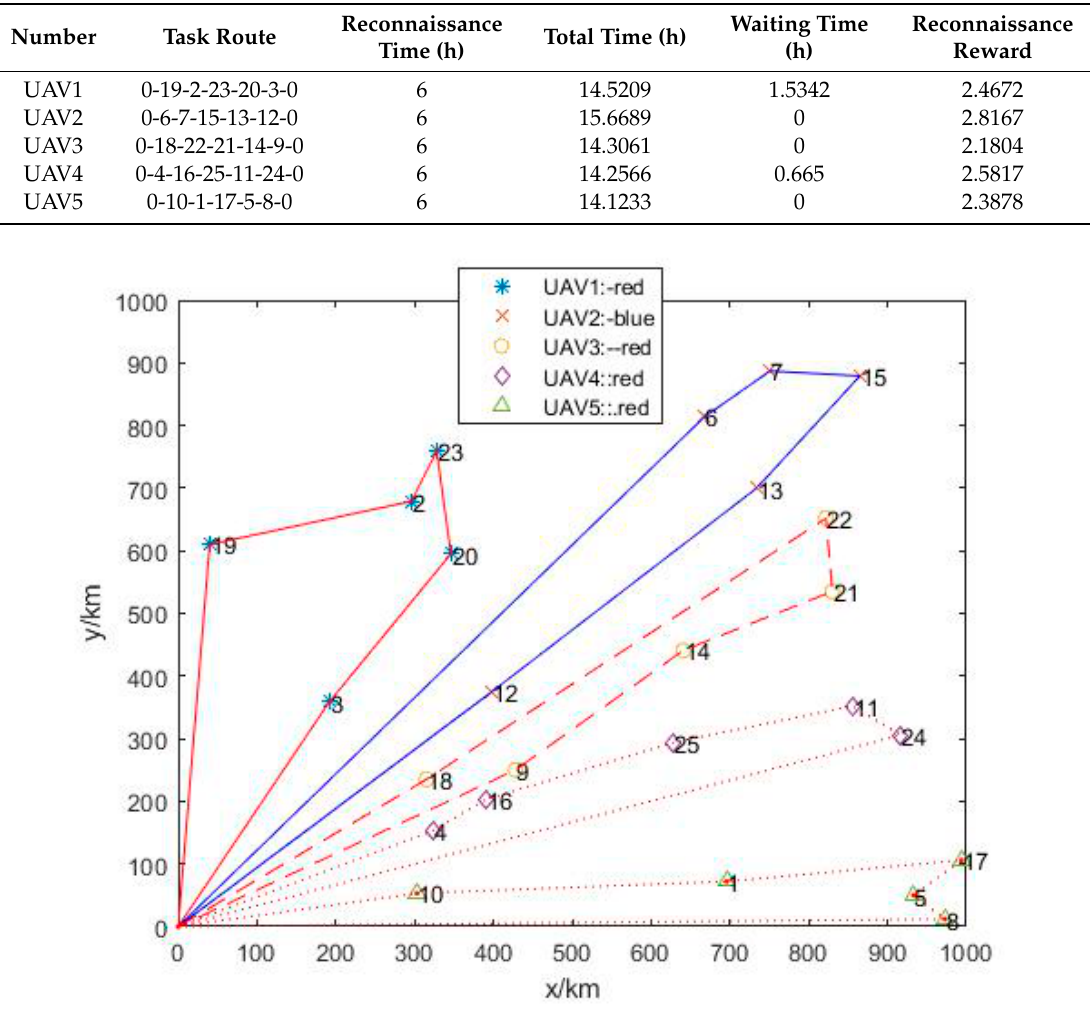
Figure 5. Optimal solution of the multi-UAV mission planning problem.